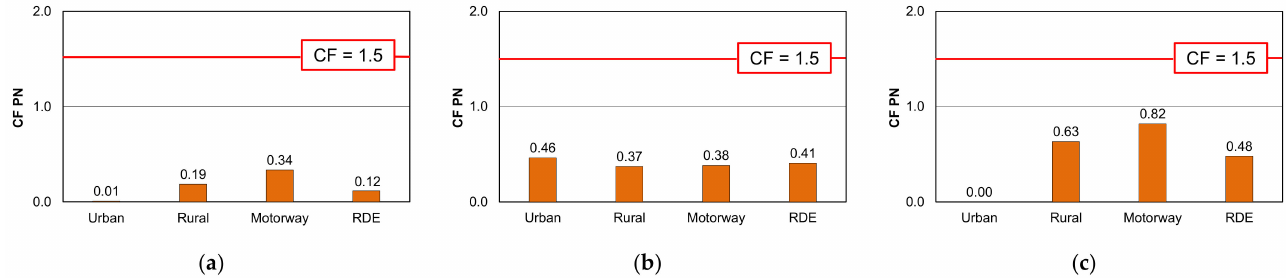
Figure 13. Conformity factors for PN emission achieved in respective parts of the tests in a passenger vehicle with a gasoline engine ( a ), a diesel engine ( b ), PHEV ( c